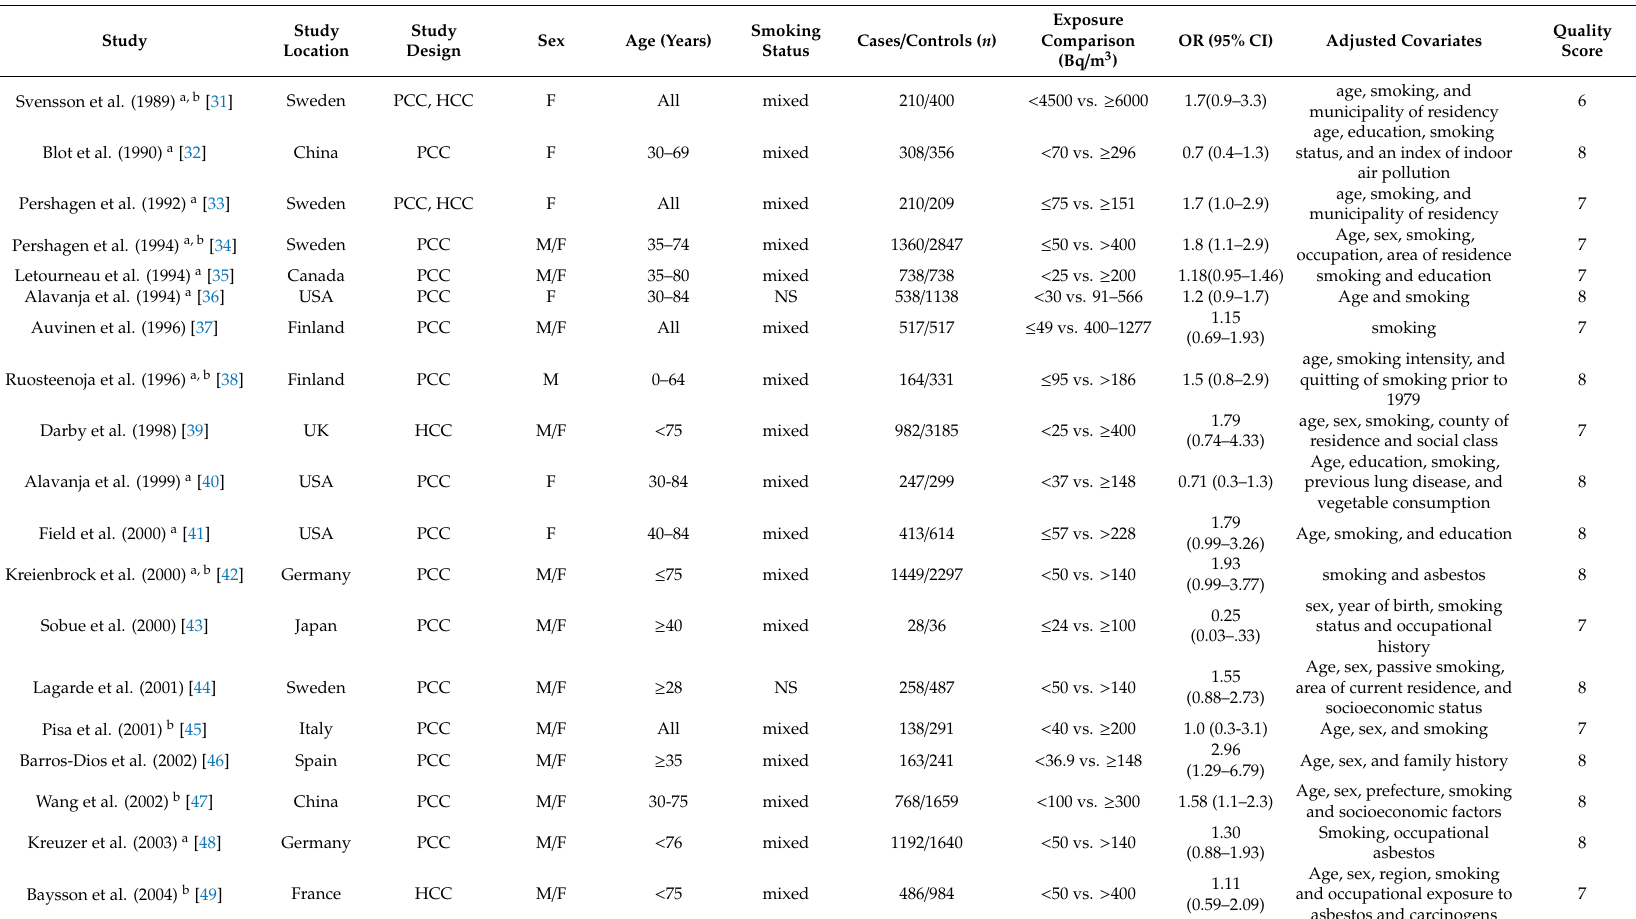
Table 1. Characteristics of studies included in the